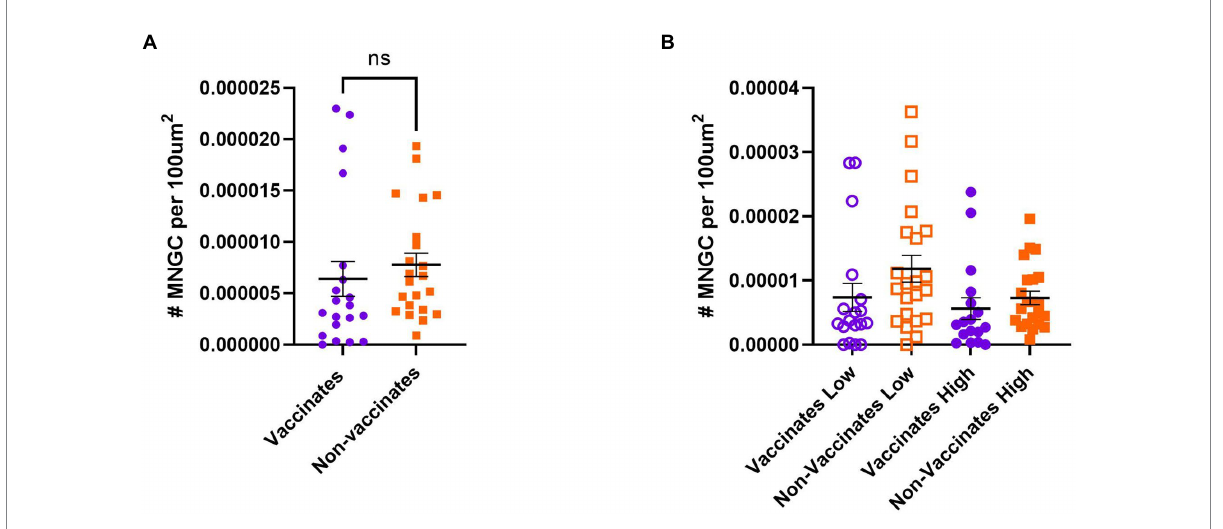
FIGURE 5 The density of multinucleated giant cells by vaccination group and granuloma grade in BCG-vaccinated and non-vaccinated cattle infected with M. bovis. Values represent the number per 100 μ m 2 and are broken down by vaccination group (A) and by vaccination group and grade (B) . Each dot represents one animal and its mediastinal and tracheobronchial lymph nodes. Values are presented as means ± SEM. (ns = not significant).